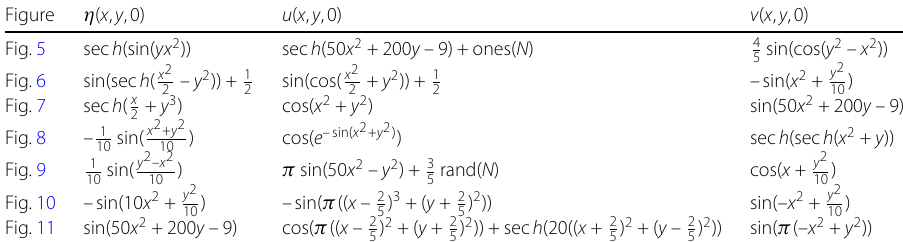
) 2 + ( y + 2 ) 2 )) + sec h (20(( x + 2 5 5